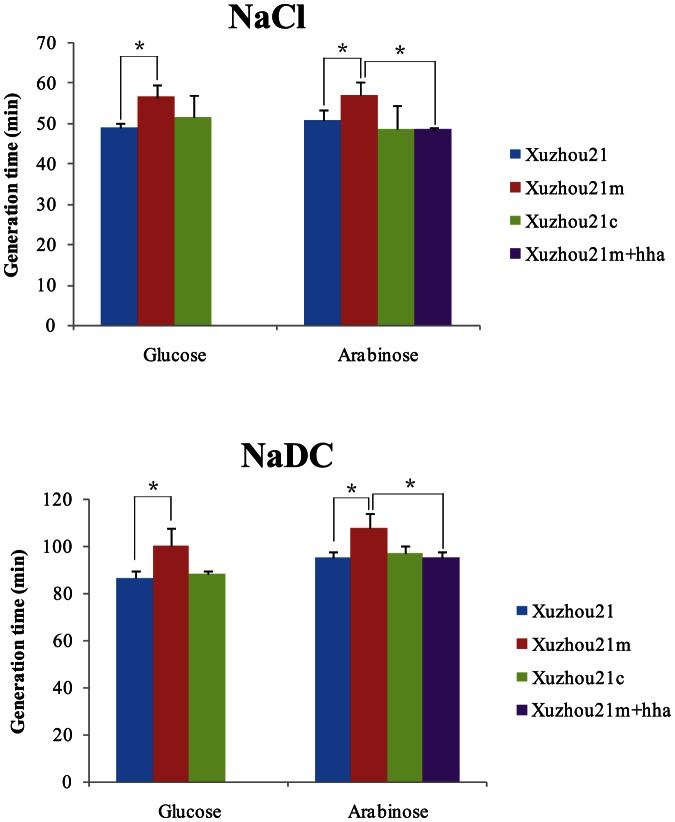
Comparison of generation time of the mutants with the wild type under different conditions.Xuzhou21, Xuzhou21m, Xuzhou21c and Xuzhou21+hha are indicated in blue, red, green and violet respectively. The generation time in M9 basal medium containing 0.2% (w/v) glucose as carbon source or 0.2% (w/v) arabinose as carbon source and hha expression inducer, and 0.37% NaCl or 0.67% (w/v) NaDC respectively. Error bars represent the standard errors from three separate growth experiments. Statistical significance (p<0.05) between Xuzhou21m and other strains is indicated by an asterisk (*).